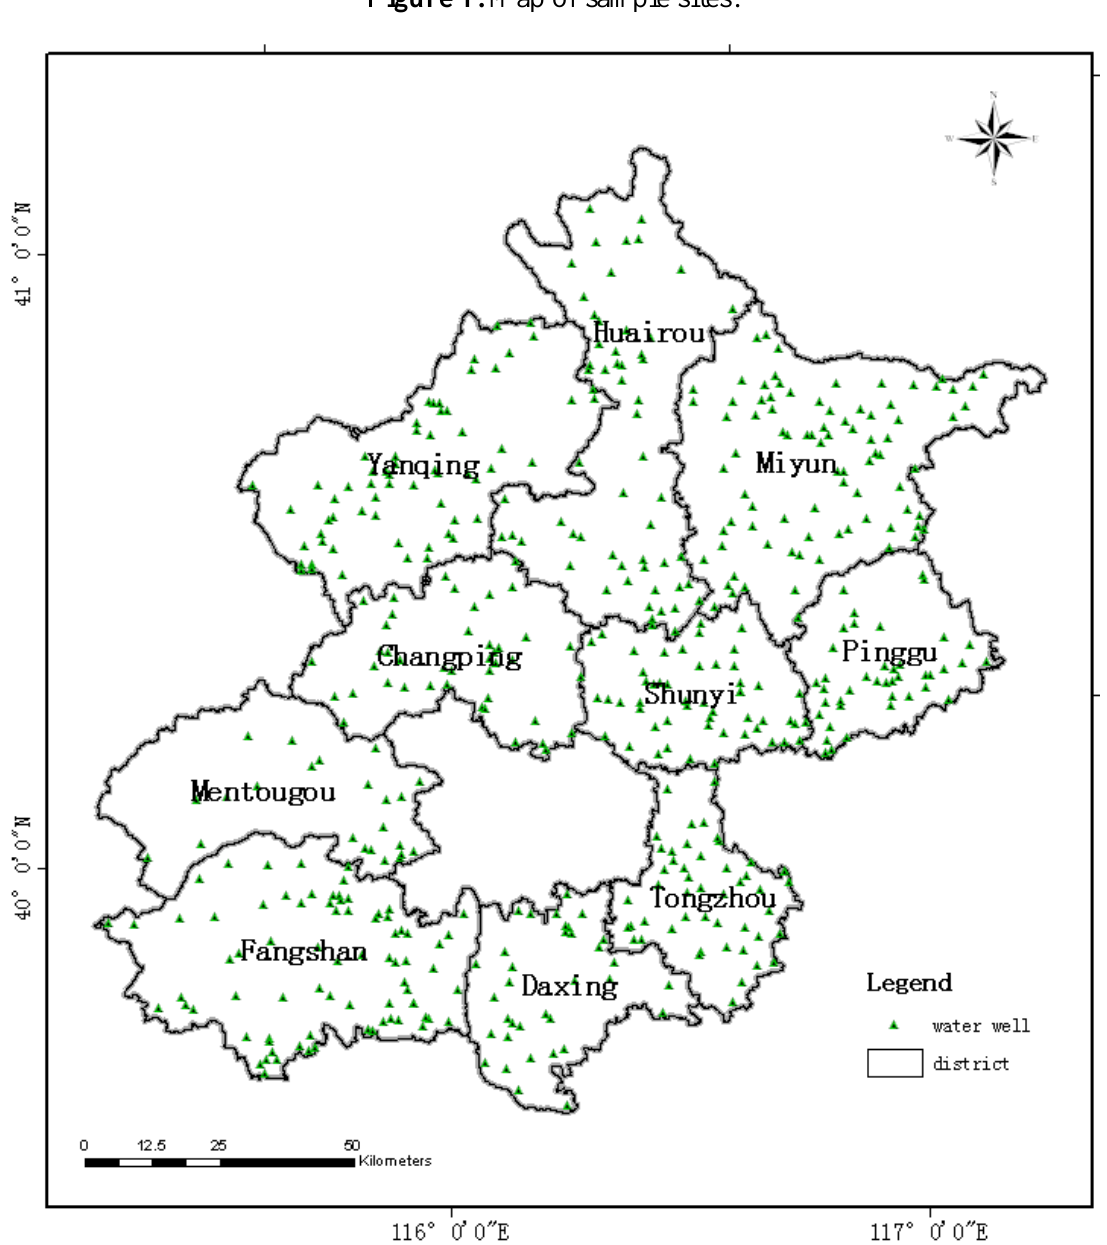
Figure 1. Map of sample